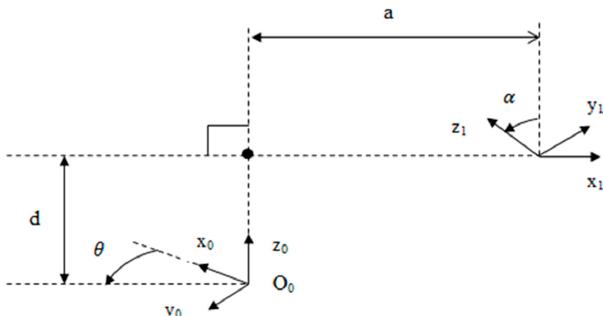
Figure 7. Angles that represent every joint, ( a ) Shoulder type, ( b ) Elbow type and ( c ) Wrist type.